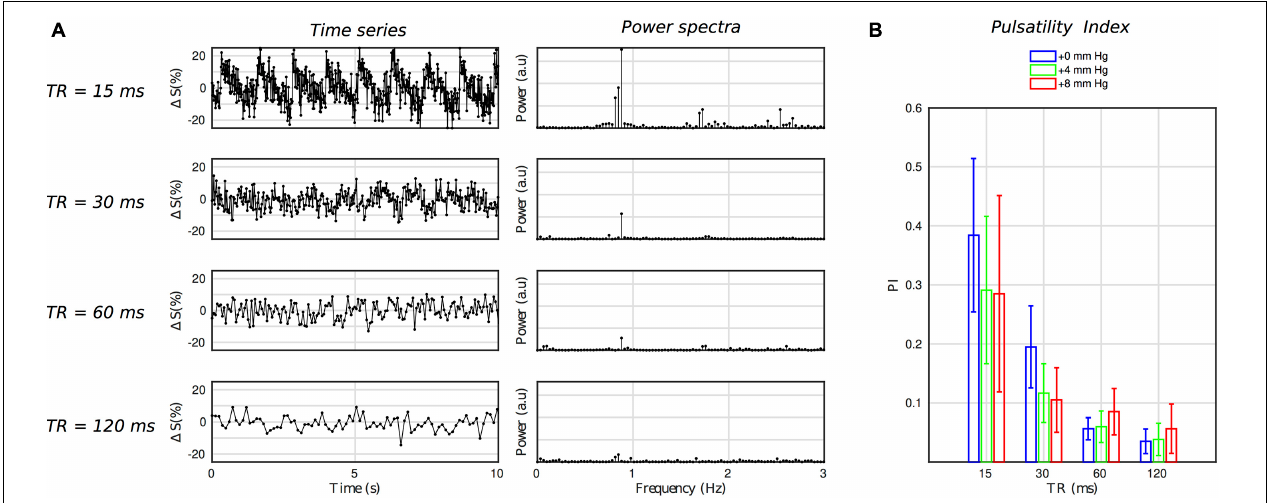
FIGURE 5 | (A) Example (subject 1) time series and their power spectra for each TR condition. Both the time series and power spectrum make it clear that there is a strong degree of pulsatility for the TR15 conditions, which falls away with higher TR values as predicted by the theory. (B) The pulsatility index for each TR and HC condition, which quantitatively confirms that which is observed in panel (A)